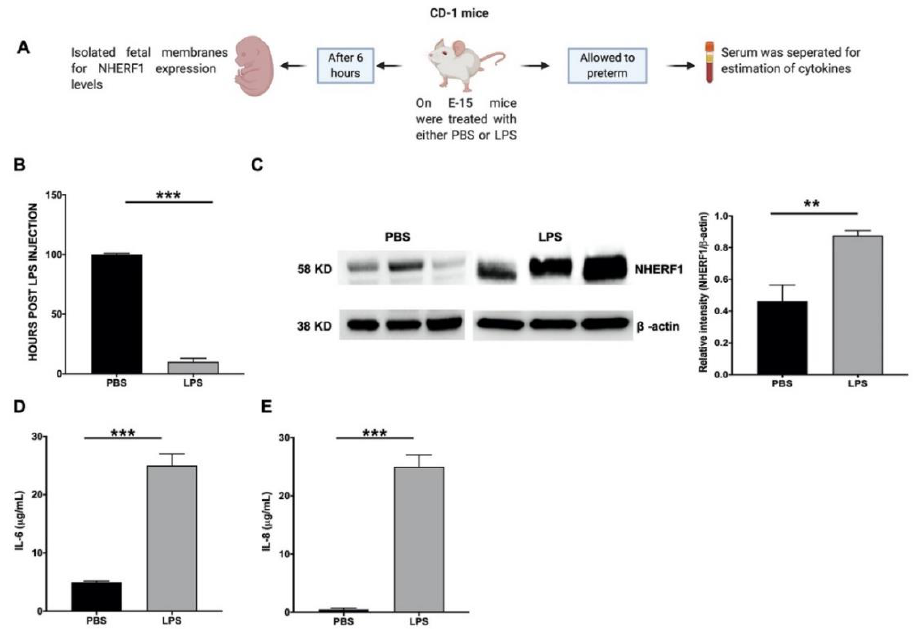
Figure 3. Expression of NHERF1 in lipopolysaccharide (LPS)-induced murine model for preterm birth. ( A ) Schematic representation of LPS-induced preterm birth model is shown. ( B ) Survival rate graph of LPS-induced pregnant mice. ( C ) Fetal membranes from cohorts of mice that were exposed to phosphate-bu ff ered saline (PBS) or LPS were subjected to western blot analysis to determine NHERF1 levels. ( D , E ) The maternal serum was collected for the estimation of proinflammatory cytokines IL-6 and IL-8. Data is shown as mean fold change ± SEM with a total of six samples per cohort. Statistical significance was calculated using an unpaired student’s t -test *** p ≤ 0.001 and ** p ≤